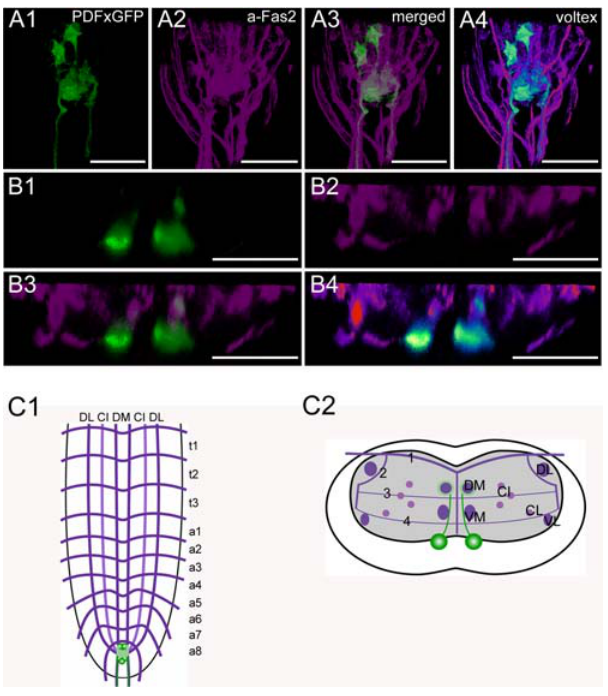
Figure 11. Morphology of PDF neurons. Mapping of pdf -GAL4xUAS- cd8.gfp expressing neurons in whole-mount preparations of the thoracic and abdominal neuromeres of L3 larva in the Fas2 landmark system. A) Dorsal view of the posterior part of the VNC. B) Transversal view at the height of neuromere a8. C) Idealized dorsal scheme. D) Idealized transverse scheme. Scale bars: 50 m m in A ), 25 m m in B ). Marker protein expression is shown in green, Fas2 in magenta.